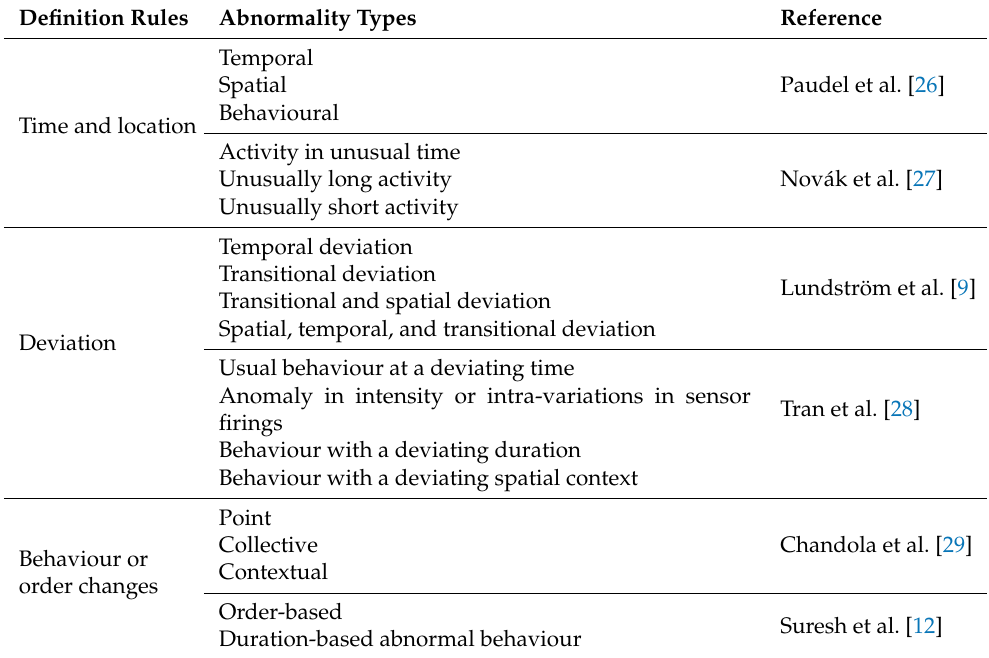
Table 2. Abnormal activity